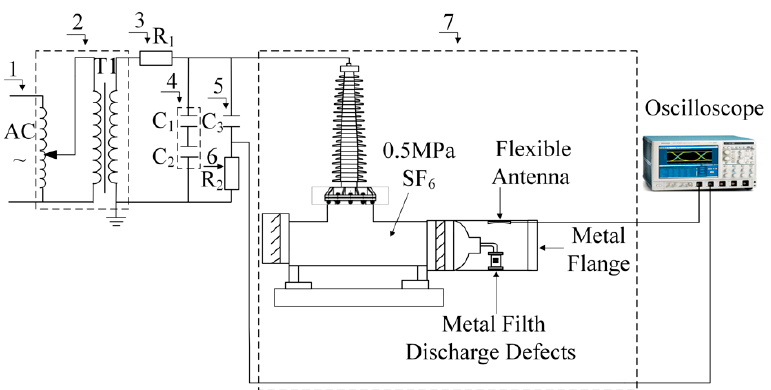
Figure 15. Typical pulse current method PD measurement circuit: ( a ) the coupling device is con- nected in series with the coupling capacitor; ( b ) the coupling device is connected in series with the test sample.